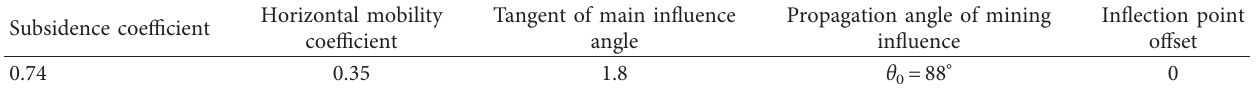
Table 1: Prediction parameters of mining subsidence.